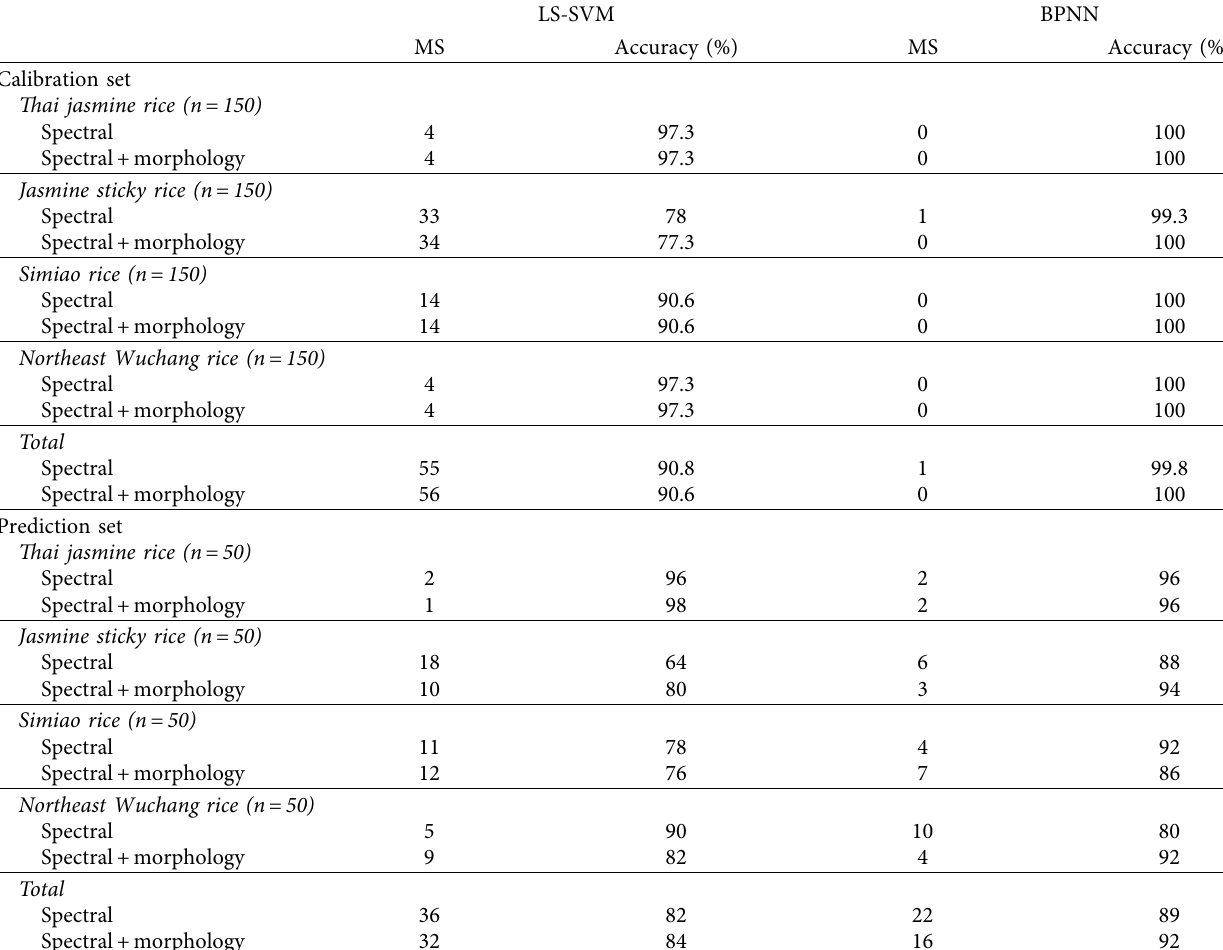
Table 2: Comparison of discrimination performance obtained with LS-SVM and BPNN methods with the spectral data and the combined spectral and morphological features